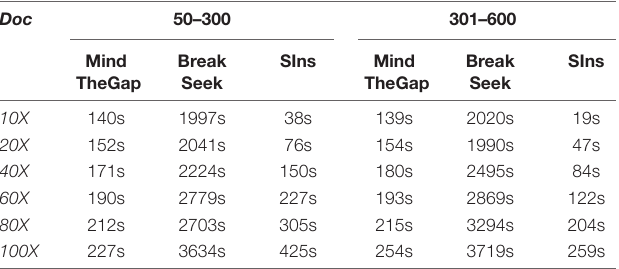
TABLE 5 | Heterozygous results obtained with four